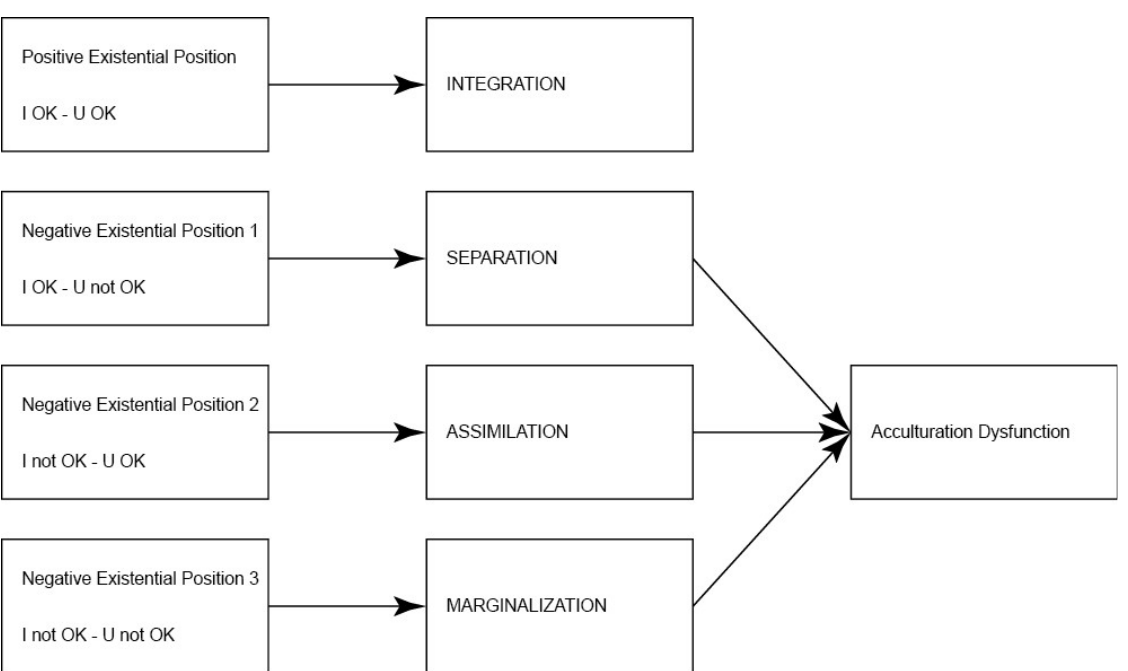
Figure 4: The idea of (inter)relatedness among the four Existential Positions and four Styles of Acculturation and with the Acculturation Dysfunction.